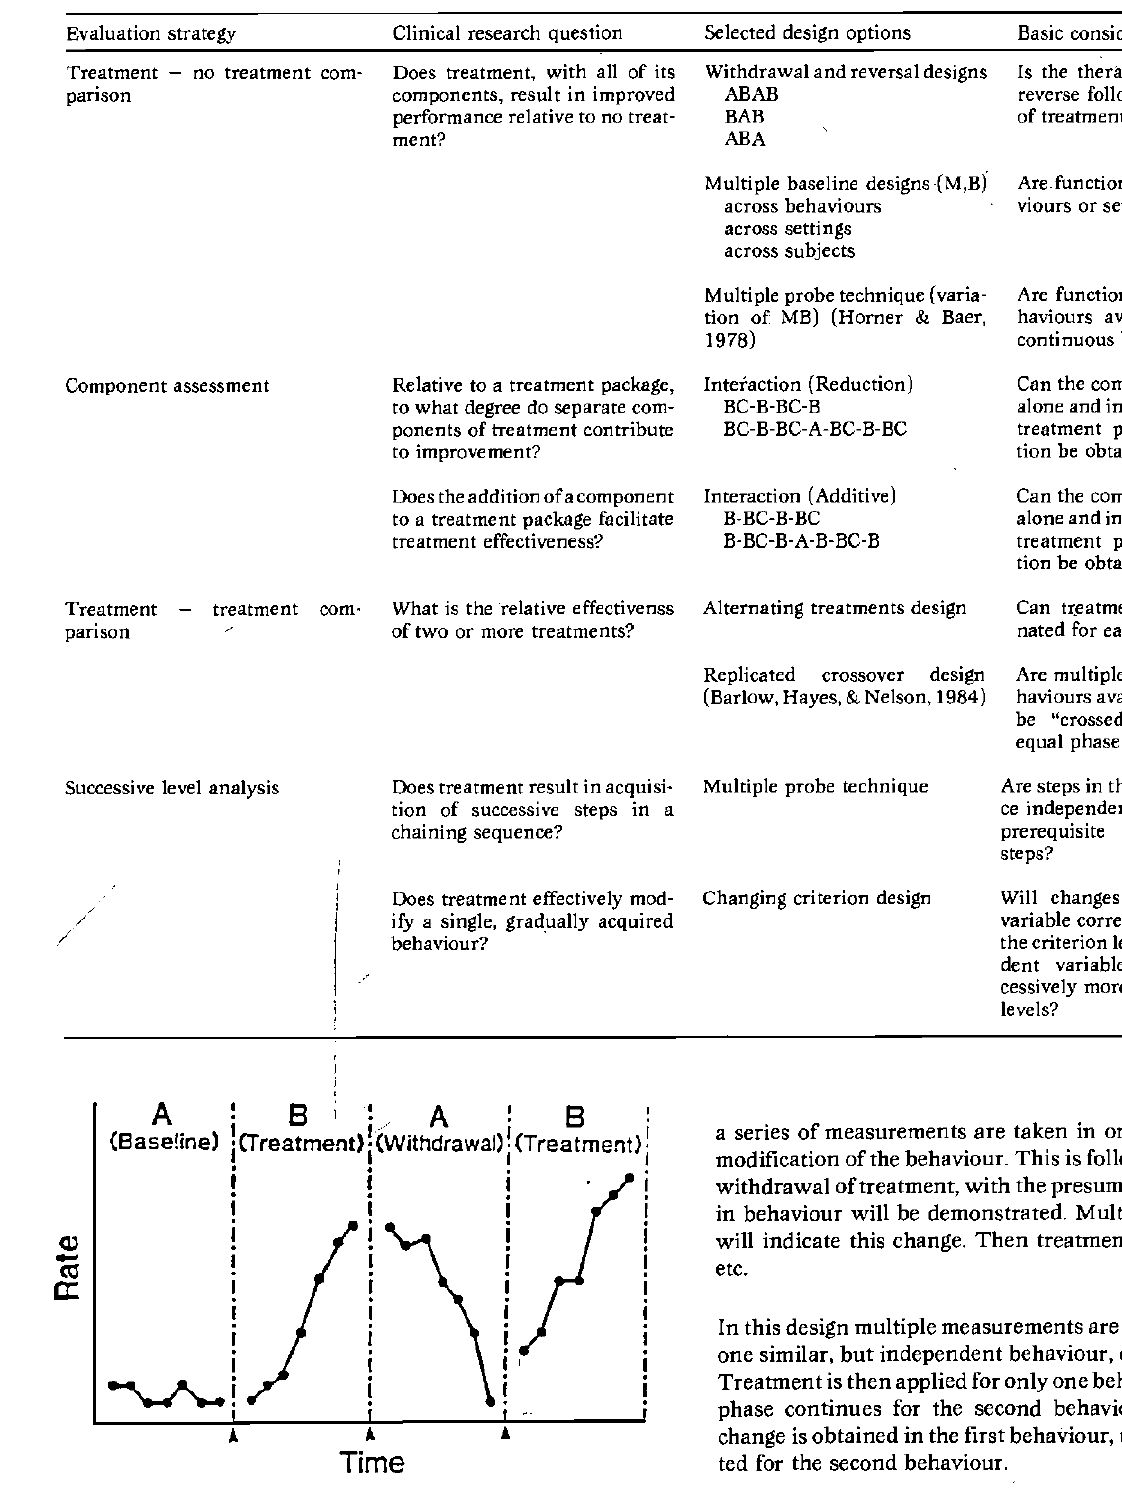
Figure 1: A basic ABAB withdrawal design with the alter- nation of no treatment and treatment